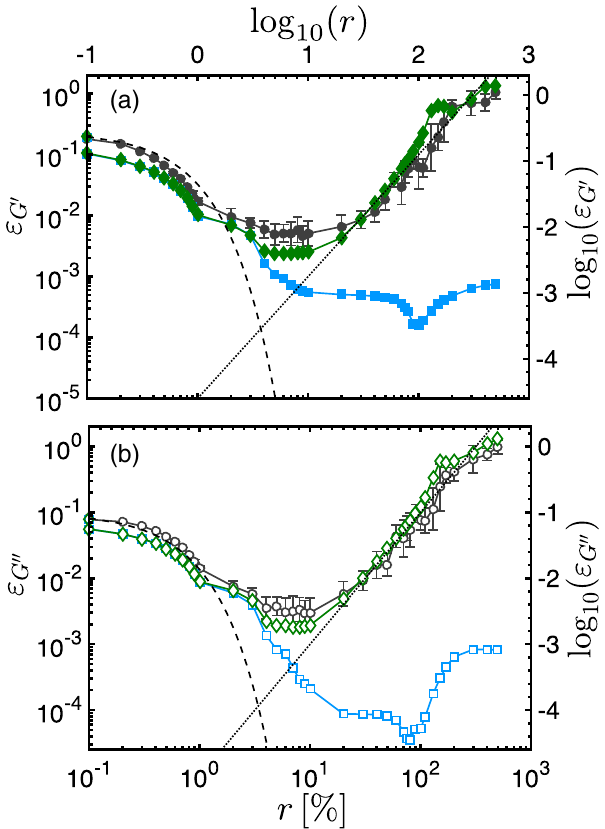
FIG. 3. Summary and comparison of experiments and numeri- cal simulations on the reference PIB solution. The plots show the rms error in the determined storage modulus (a) and loss modulus (b), defined in Eqs. (6) and (7), as a function of the tapering parameter r . Black circles ( ε , filled circle; ε , open circle) G 0 G 00 show the experimental results averaged over six different real- izations. Error bars correspond to one standard deviation. Blue squares ( ε , filled; ε , open) are the results from numerical G 0 G 00 simulations without noise, while green diamonds ( ε , filled; ε , G 0 G 00 open) show the trend from simulations when Gaussian noise is added to the stress signal in order to mimic experimental conditions. The dashed line is an exponential fitting to the data for r < 1% , while the dotted line shows the quadratic divergence of the error for r > 15%